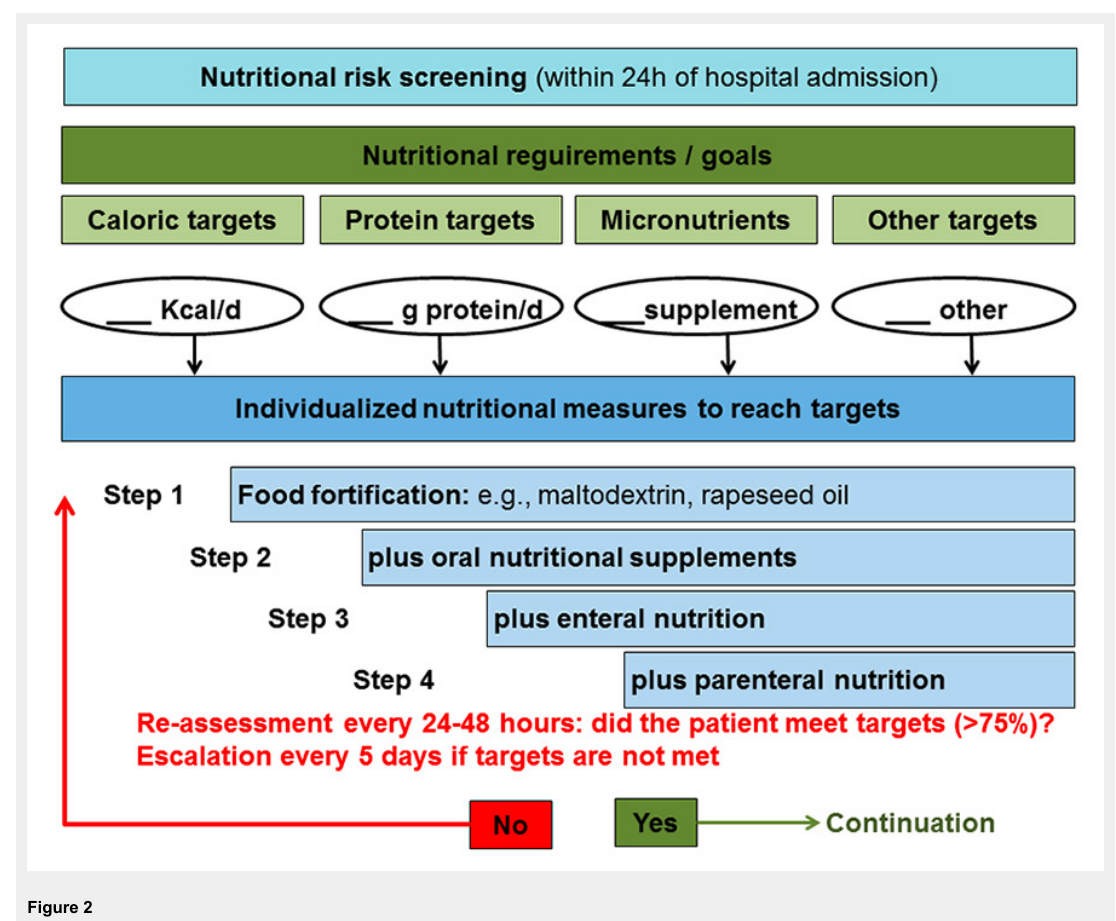
Figure 2 Nutritional strategy in medical inpatients at risk for